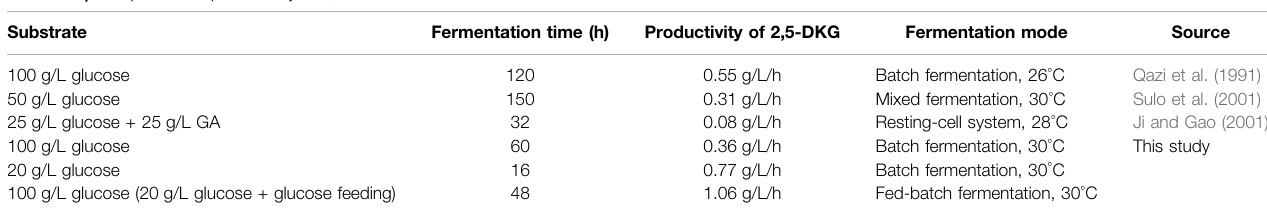
TABLE 3 | Comparison of productivity of 2,5-DKG in different